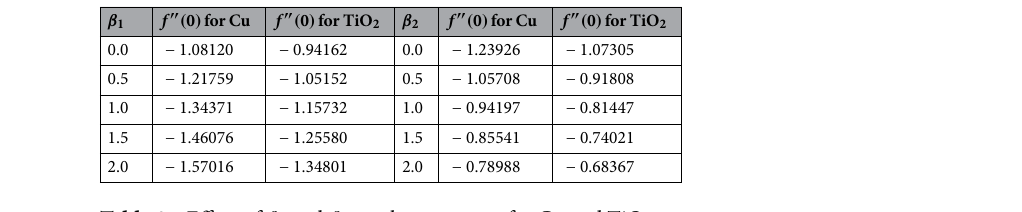
Table 3. Effect of β 1 and β 2 on shear stresses for Cu and TiO 2 .